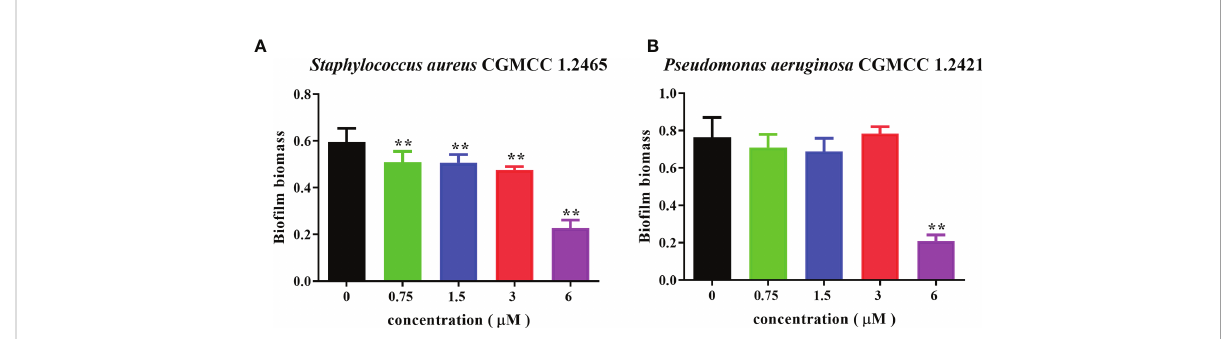
FIGURE 11 Inhibitory effect of Spgillcin 177 – 189 on S. aureus and P. aeruginosa bio fi lm formation. (A) S. aureus and (B) P. aeruginosa were incubated without or with different concentrations of Spgillcin 177 – 189 . Bio fi lm mass was quanti fi ed by crystal violet staining, and then the absorbance was measured at 595 nm. Data represented mean ± standard error of mean, and the experiments were of three biological replicates completed independently. The signi fi cant difference between control group and Spgillcin 177 – 189 -treated group is indicated by asterisks as ** p <